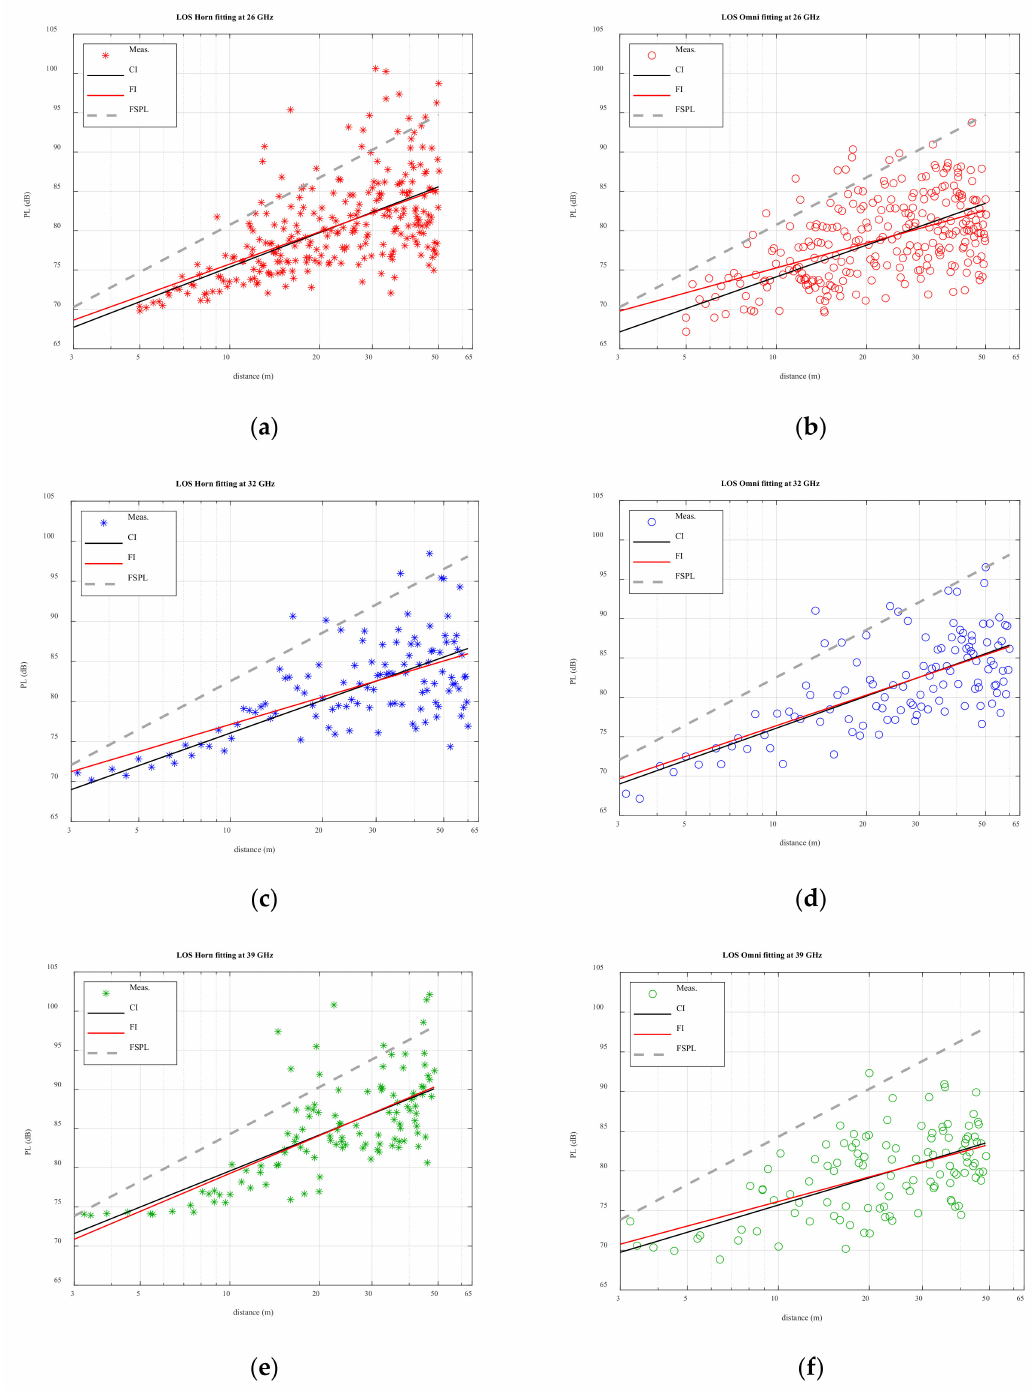
Figure 3. Close-in (CI) and floating intercept (FI) fittings for path loss results at 26 GHz ( a , b ); 32 GHz ( c , d ) and 39 GHz ( e , f ) for the Horn (left hand) and Omni (right hand) configurations. FSPL is represented in each figure in gray